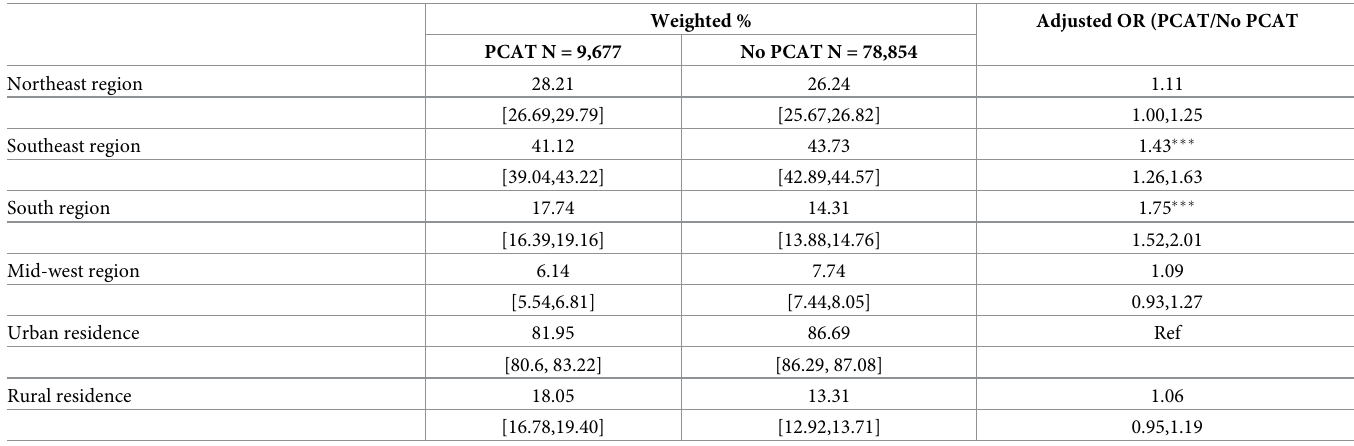
Adjusted Odds Ratios calculated using survey-adjusted weighted logistic regression that controls for all other variables listed in table. � p < 0.05 �� p <